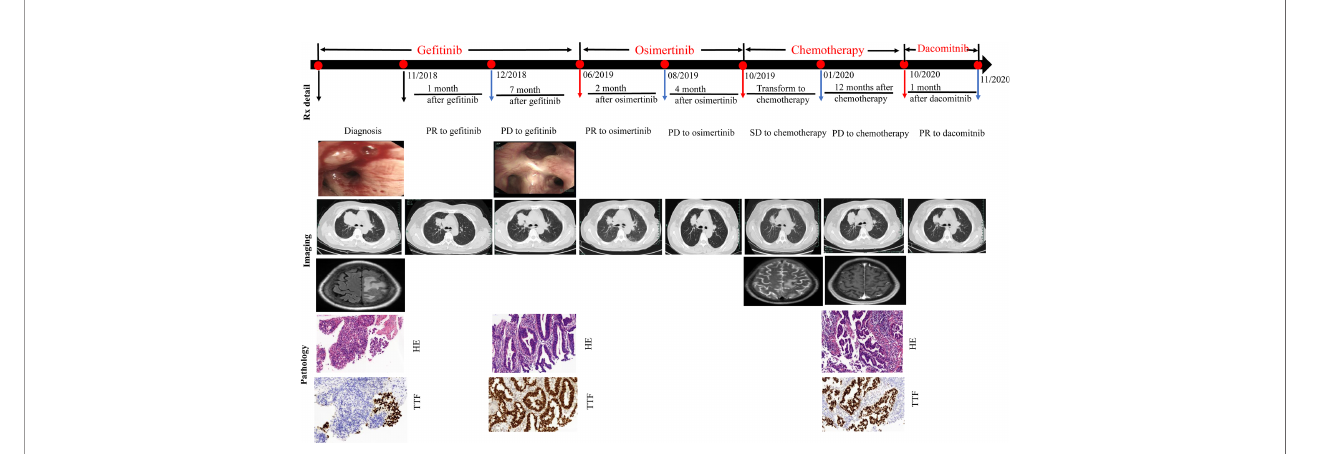
FIGURE 1 | Evolution of the disease in case presentation. CT, computed tomography; HE, hematoxylin and eosin; Syn, synaptophysin; Rx,